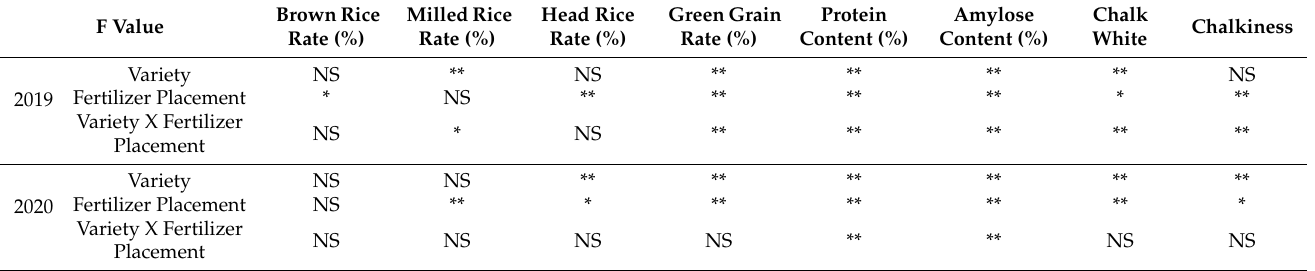
Table 5. The effects of interactions between varieties and fertilizer placement on fragrant rice